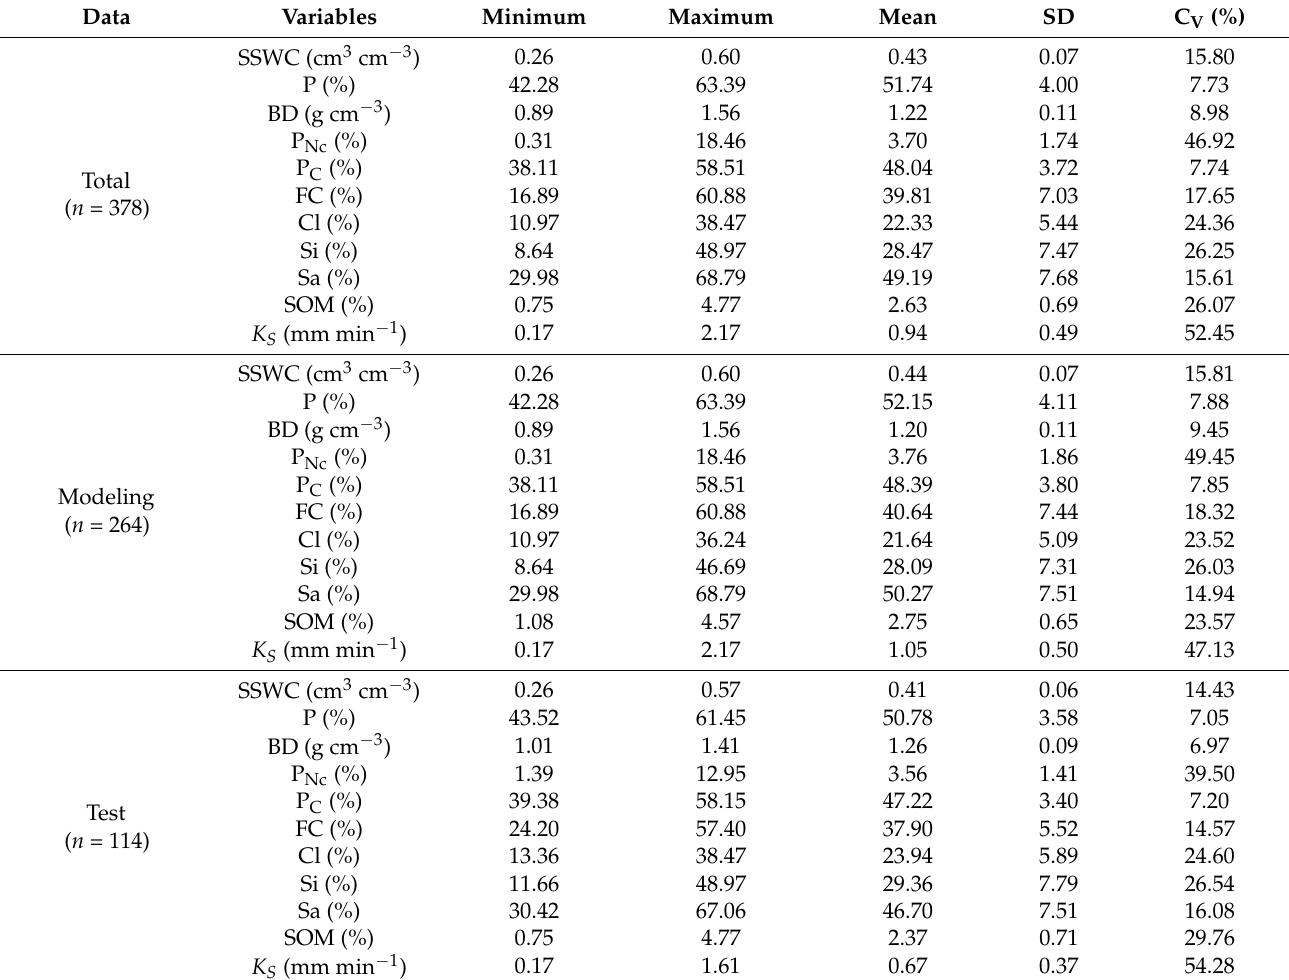
Table 1. Descriptive statistics of soil properties for a total dataset, modeling dataset, and test dataset. Data